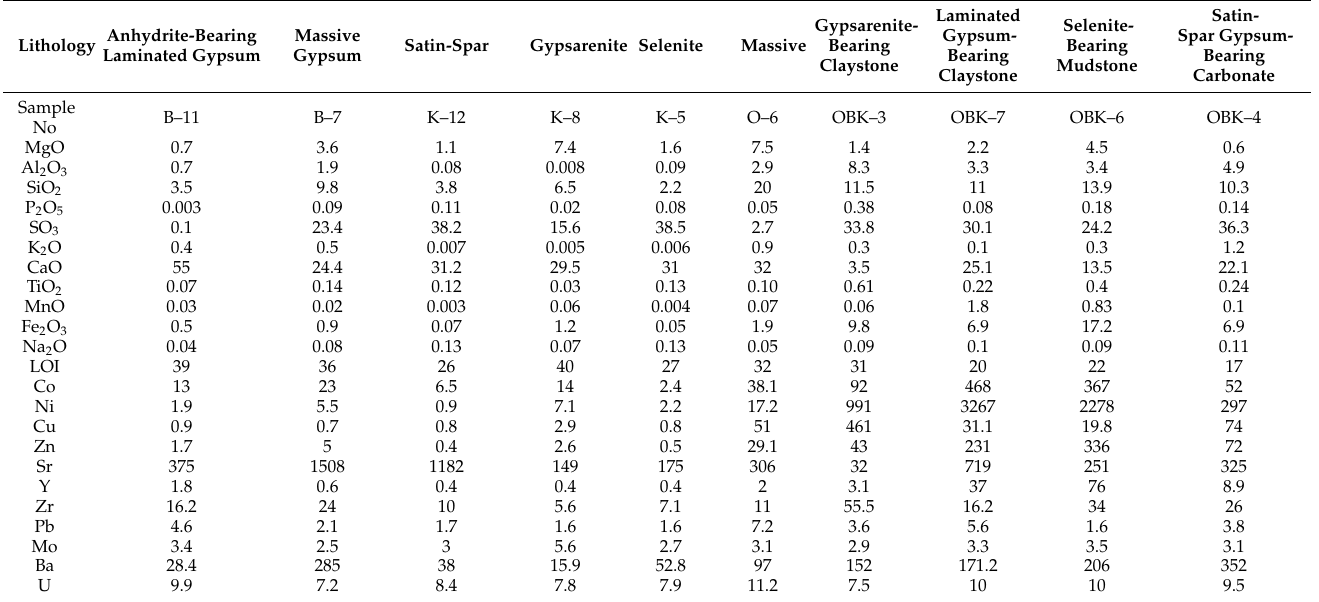
Table 1. Major (%) and trace element (ppm) values of the different evaporite rock samples intercalated with clastic and